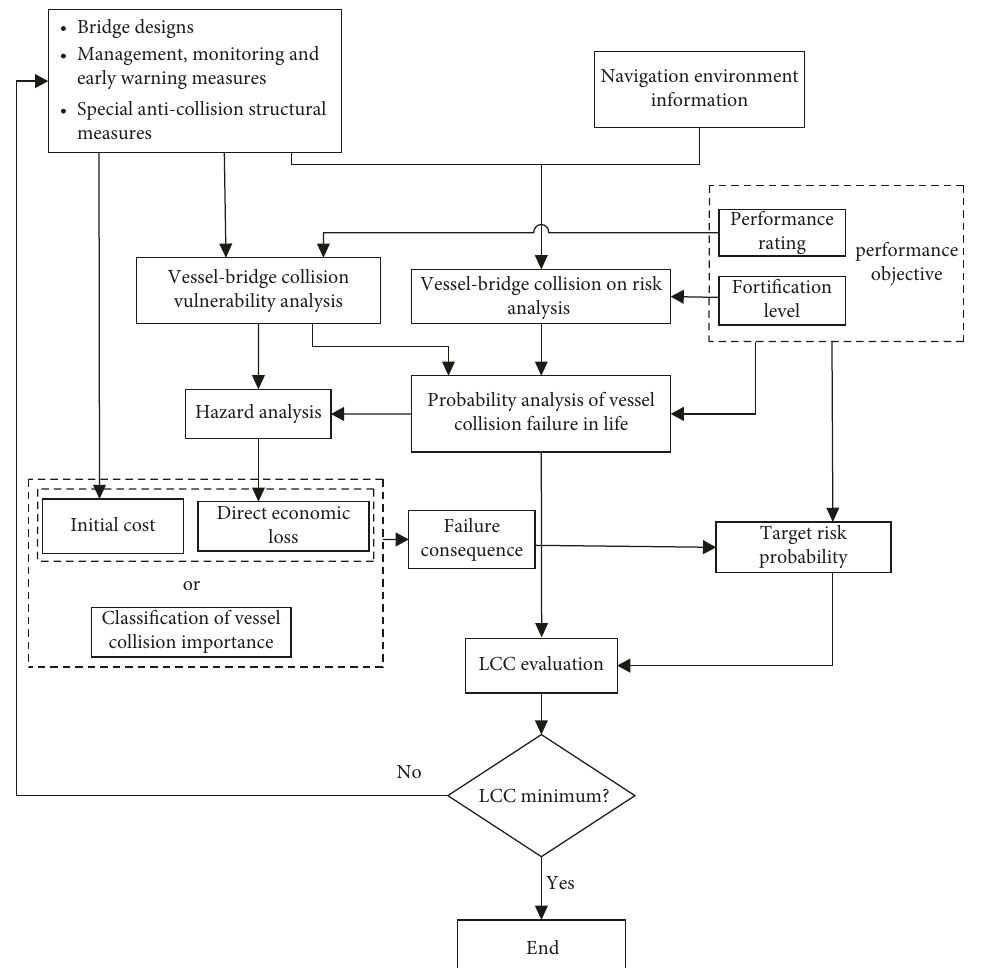
Figure 2: Vessel-bridge collision life-cycle cost design